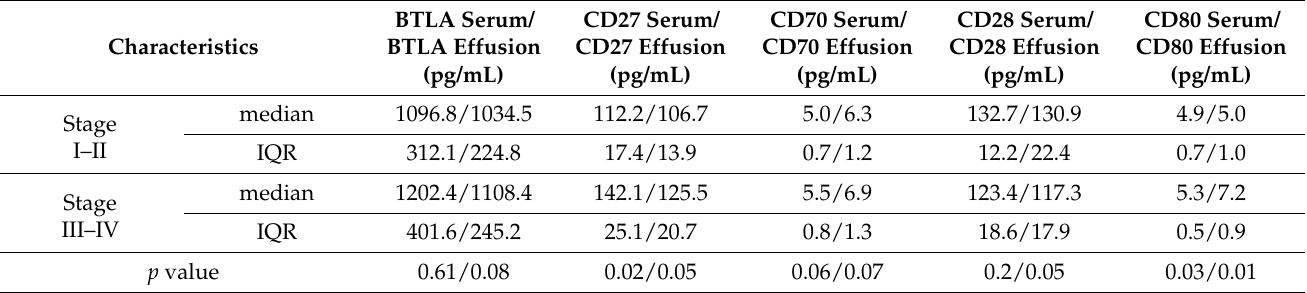
Table 4. Levels of serum and peritoneal fluid concentrations of the studied proteins in the compared tumor clinical stage